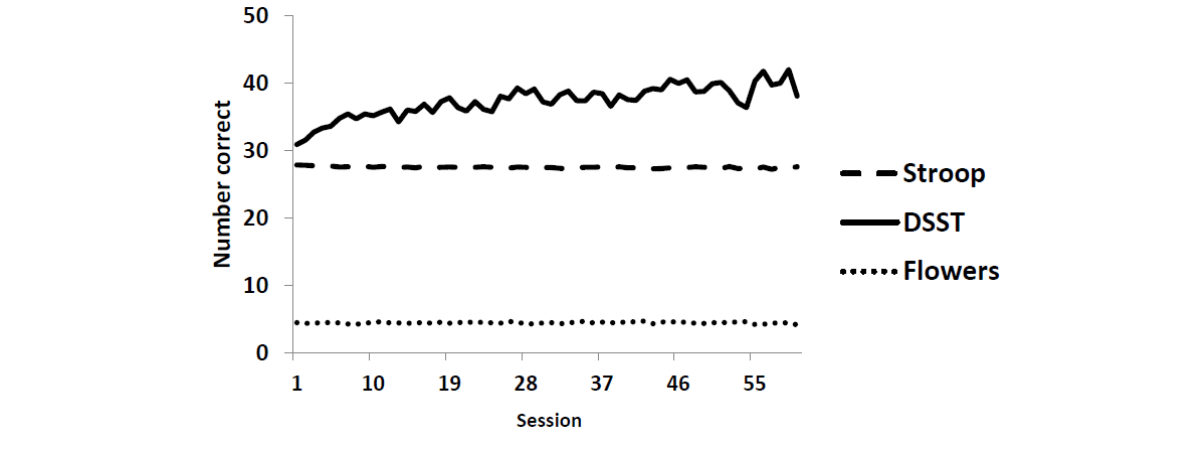
Figure 3. Average number of correct responses across sessions: flowers, marijuana Stroop, and digit symbol substitution task tasks. DSST: digit symbol substitution